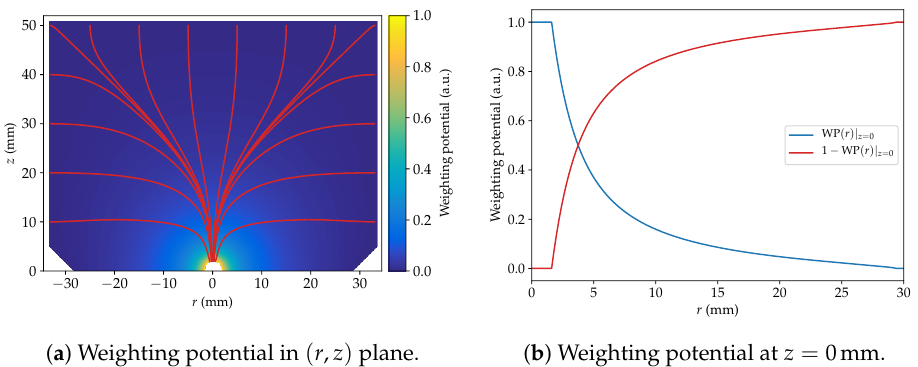
Figure 2. ( a ) Weighting potential (WP) of the investigated PPC detector in the ( r , z ) plane. Red lines indicate the hole drift paths. ( b ) Radial dependence of the WP at the passivated surface ( z = 0mm). The WP was simulated using mjd_fieldgen